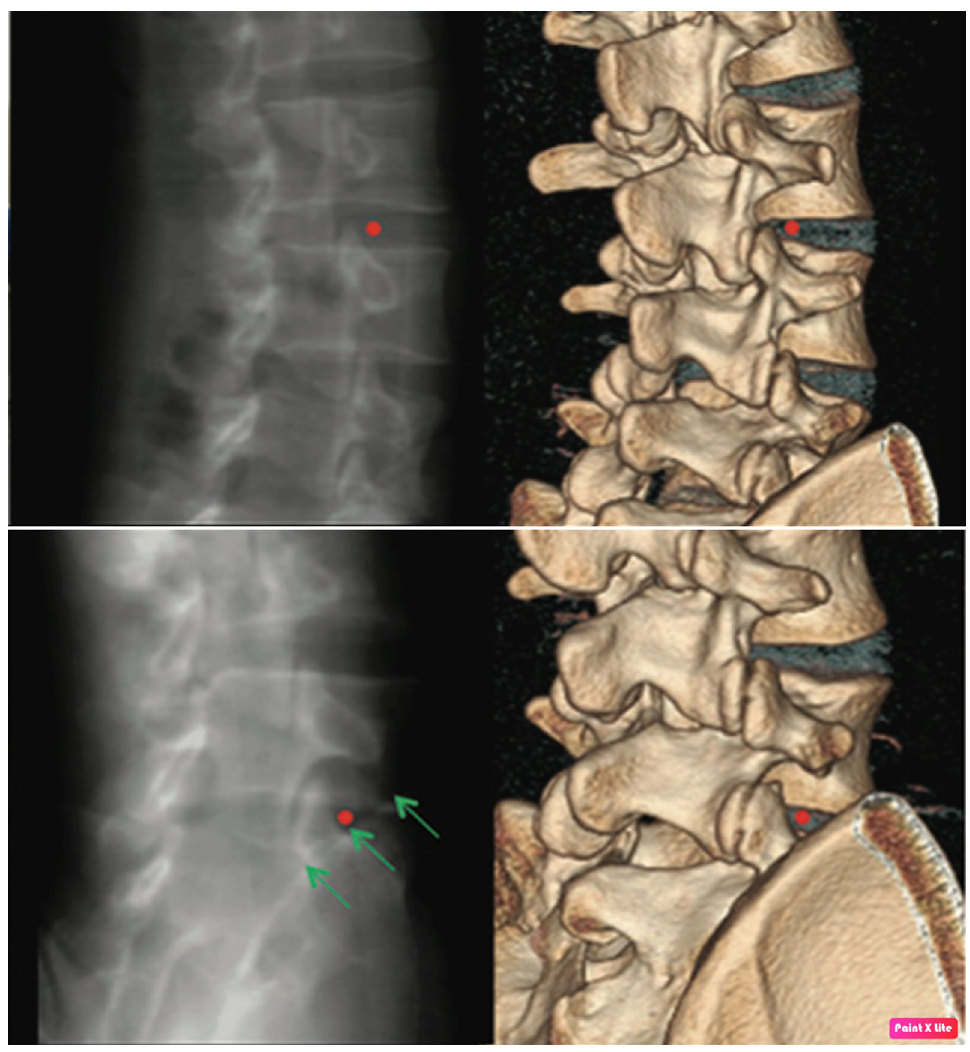
Fig. 6 Above, the proper fluoroscopic view and target “red dot” for access of L1-2 to L4-5 disc levels. Below, the proper view for L5-S1 disc space access showing the triangular window medial to the iliac crest “green arrows” and the ideal target location “red dot”. (Reproduced from